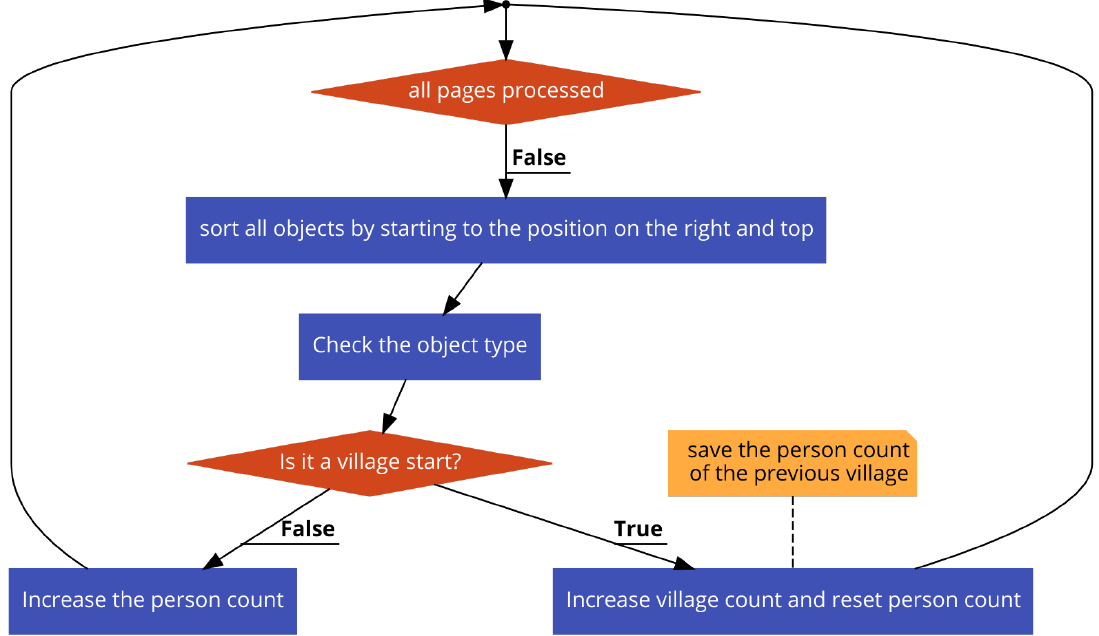
Figure 6. Flowchart of our populated place assigning